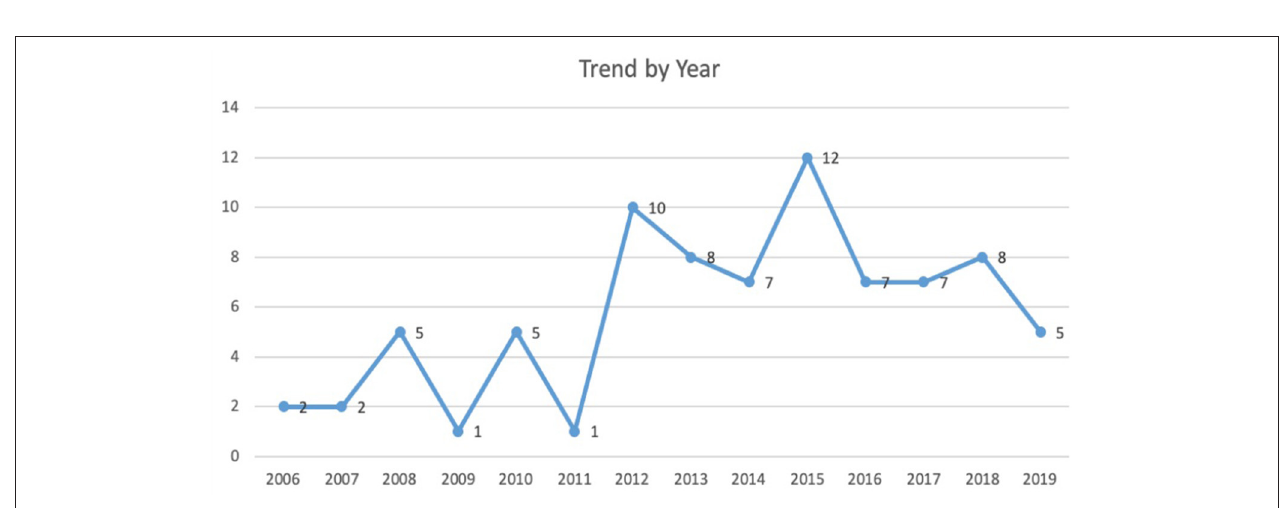
FIGURE 2 | Mobile phone-based persuasive technology (PT) for physical activity (PA) and sedentary behavior (SB) trend by